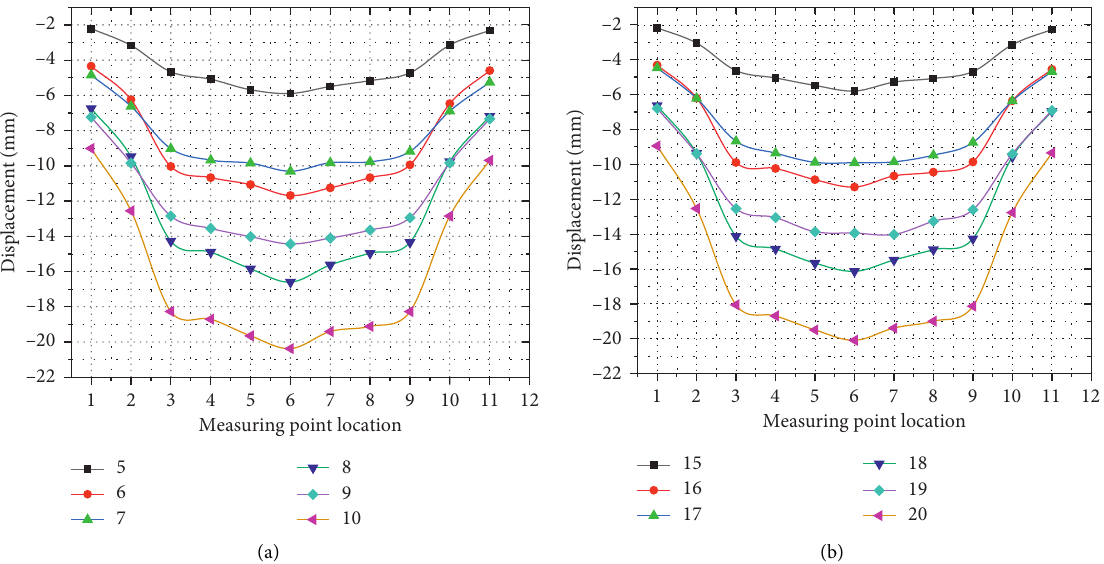
Figure 10: The maximum displacement of three segments along the width direction under various working conditions. (a) Three-tenon type segments. (b) Four-tenon type